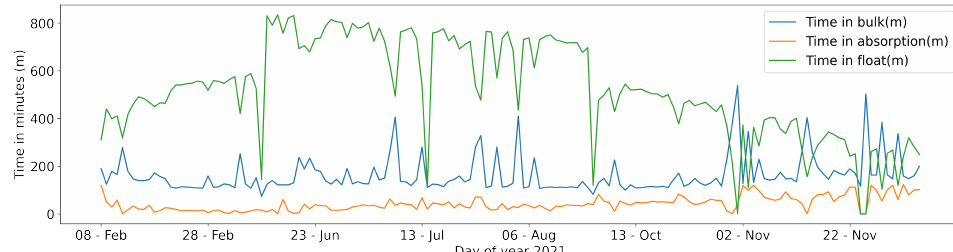
Figure 14. Time in bulk, absorption and in float.